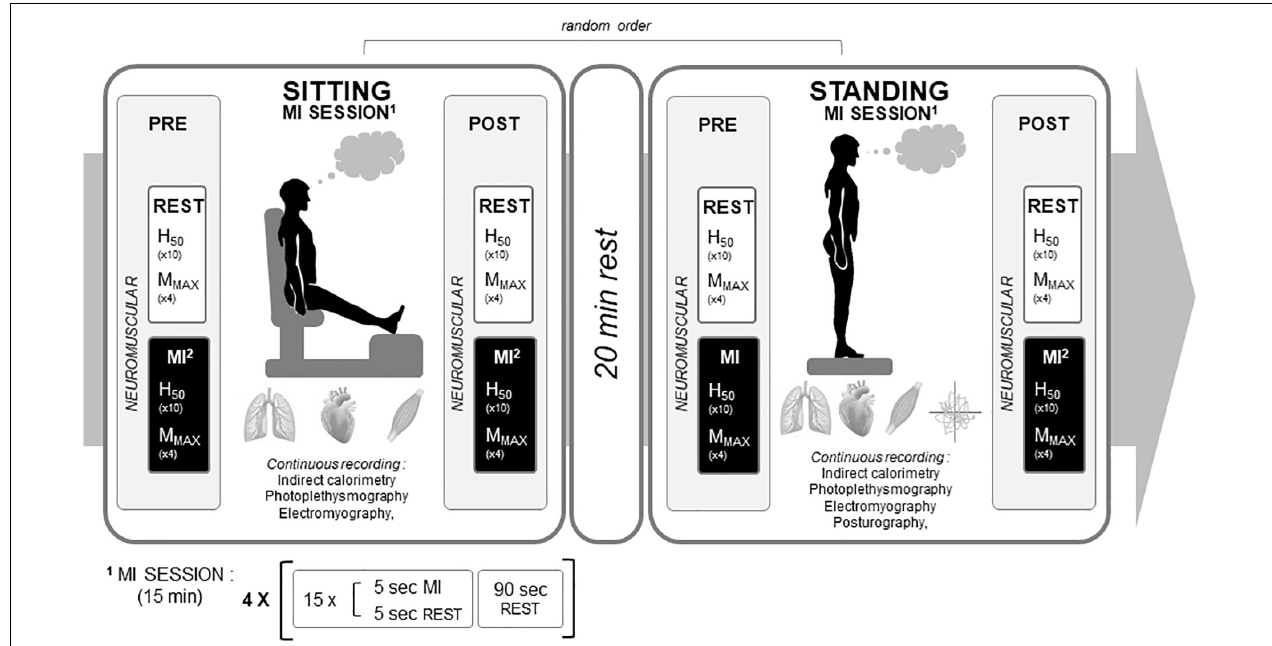
FIGURE 1 | Experimental design. An experimental motor imagery (MI) condition is depicted. The control condition had the same rationale with 15 min rest observed instead of the MI training session. H 50 : H-reflex recorded at 50% of maximal H-wave amplitude. M MAX : maximal muscle compound action